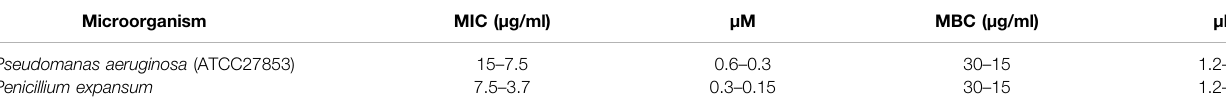
TABLE 2 | Minimum inhibitory concentration and minimum bactericidal concentration. Microorganism